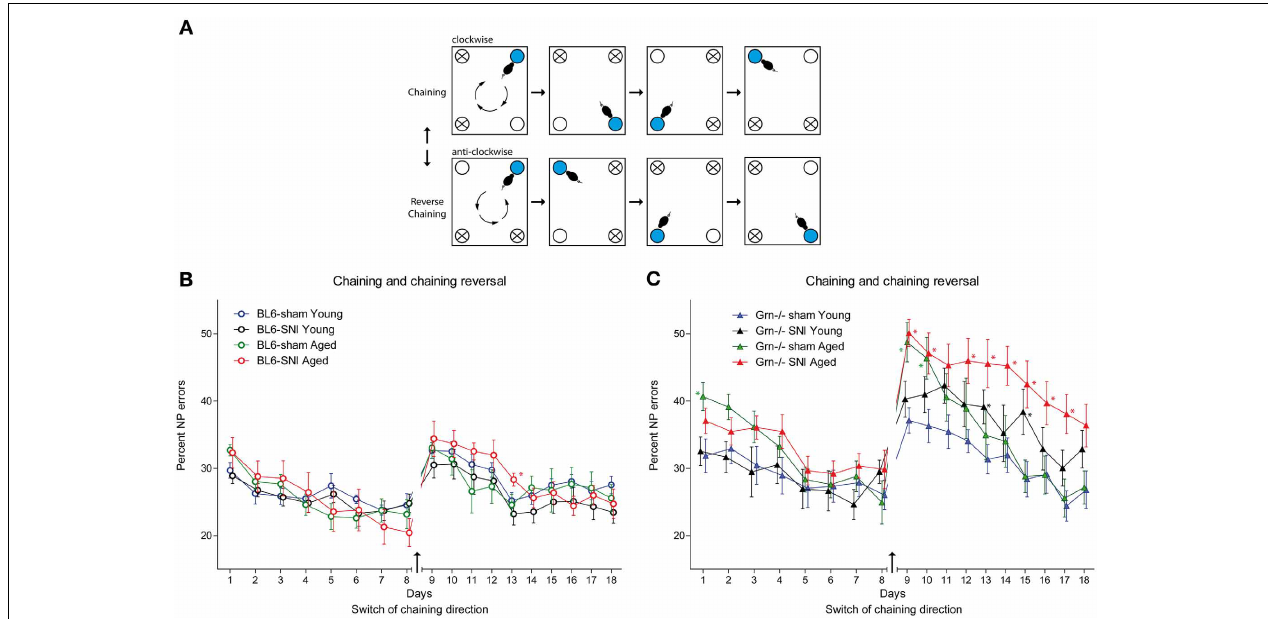
FIGURE 6 | Spatial sequence learning in young and aged C57BL6/J and progranulin deficient (Grn − / − ) mice. (A) Illustration of the “chaining” and “reversal of chaining” tasks. Mice were randomly allocated to either starting with the clockwise or anti-clockwise direction. After 8 days the direction was conversed. The blue circle indicates the awarding corner and the white circle is the corner, in which the next water award was applied. The crossed circles show the corners where water access was denied. (B,C) Time courses of